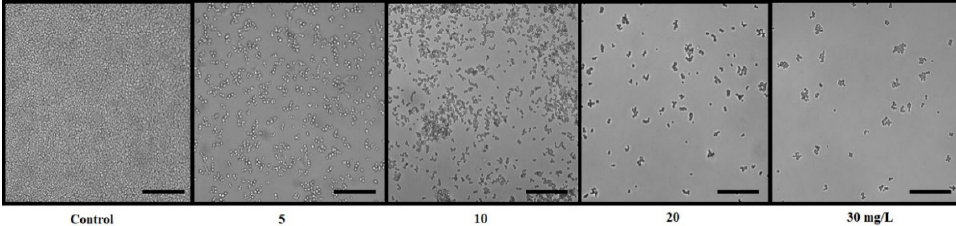
Figure 3. The influence of resveratrol in cane extract on C. albicans DBM 2164 biofilm formation visualized by a Cellavista device; scale bar 400 µm.